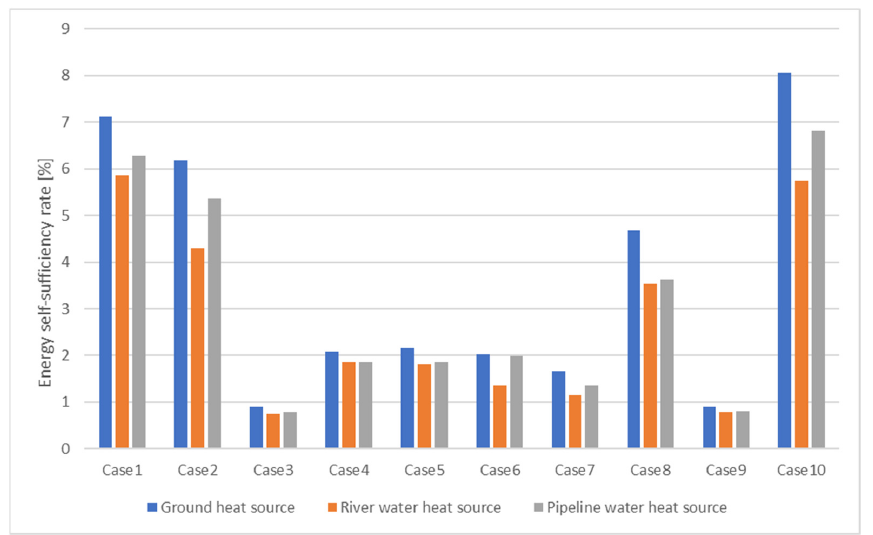
Figure 3. Comparison of ground, river water, and pipeline water heat source self-sufficiency rates for each case.